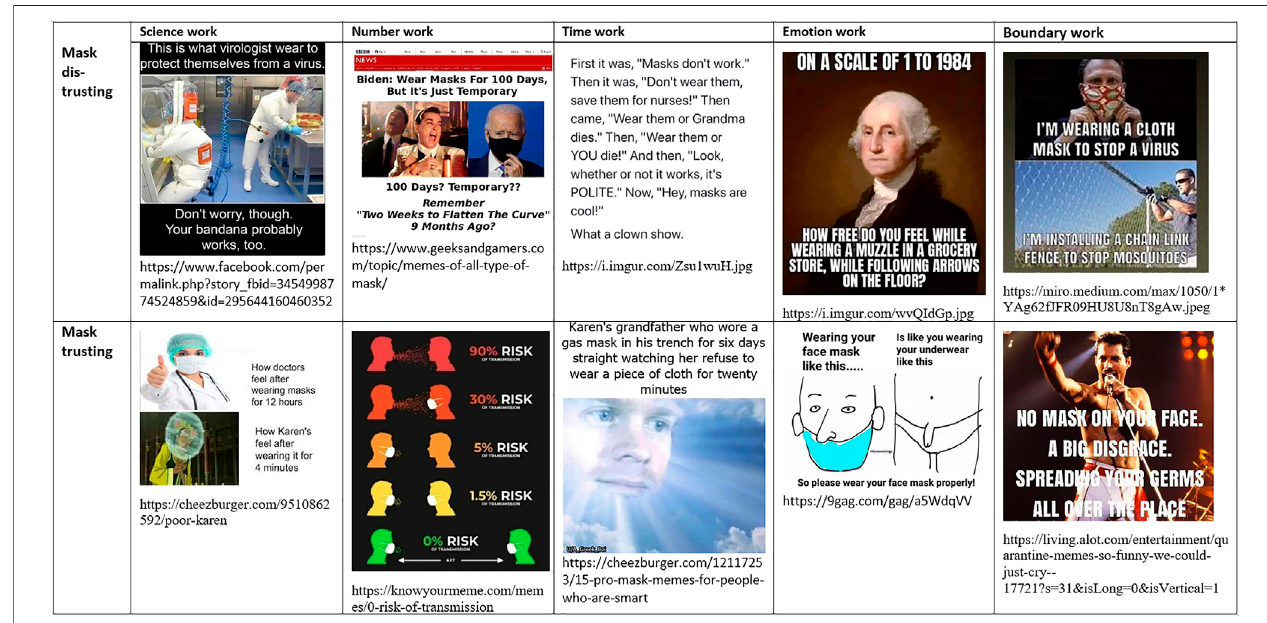
FIGURE 10 | Social construction of masks as hinge objects through science work, number work, time work, emotion work, and boundary work.